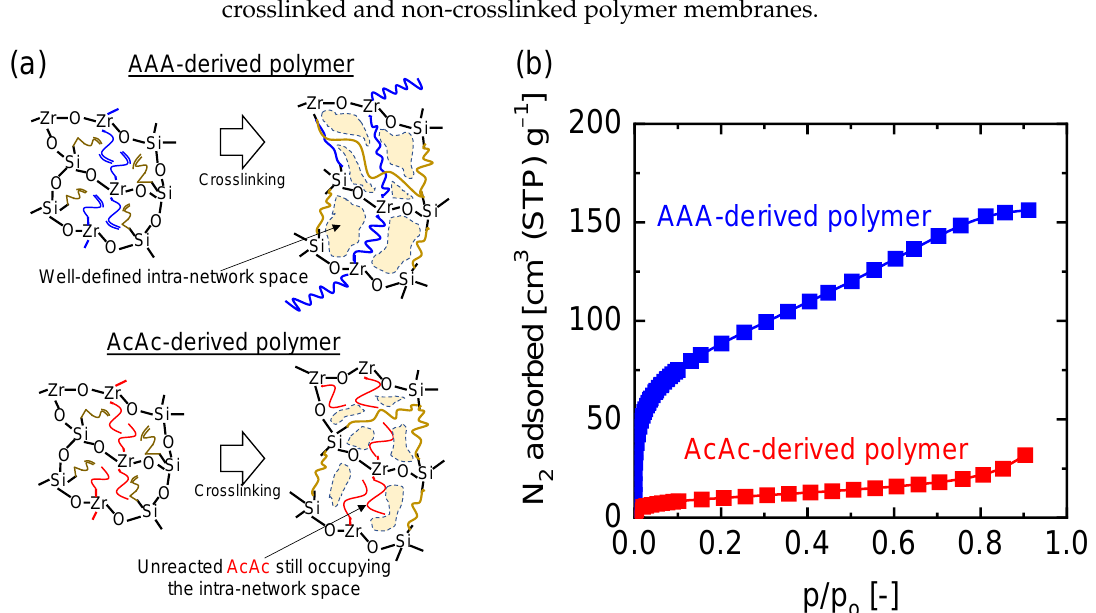
Figure 14. ( a ) Schematic illustration of the network formation in inorganic–organic hybrid polymers based on organic chelating ligand type; ( b ) N 2 adsorption–desorption isotherms for AAA- and AcAc-derived hybrid polymer powders measured at −196 °C. Results of N 2 adsorption were adapted from [93].